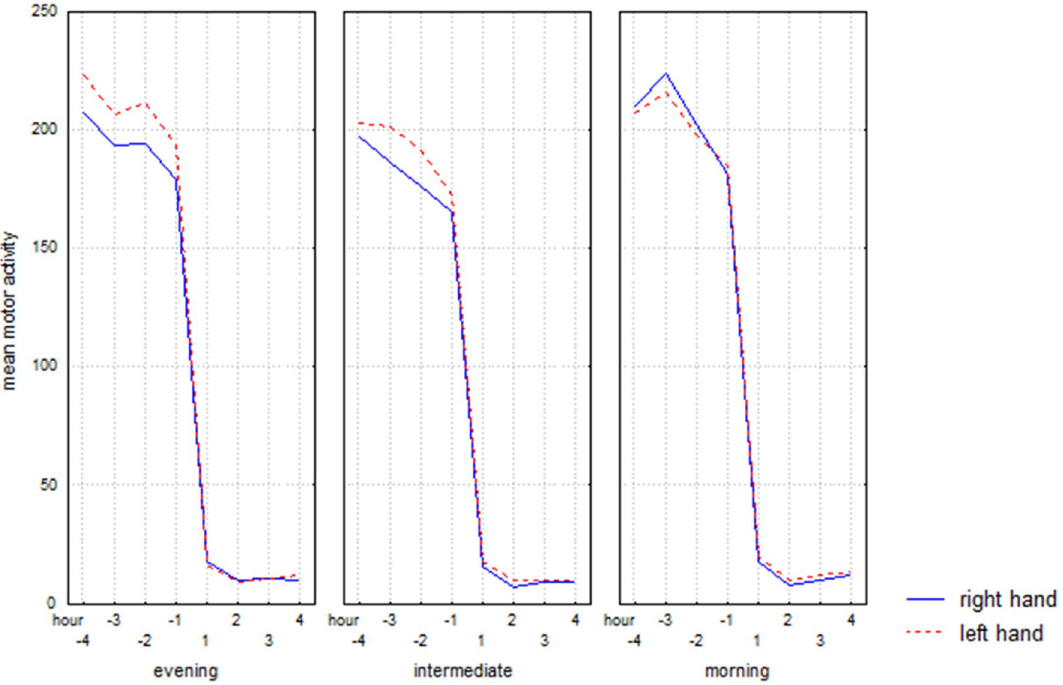
Figure 2. Hourly mean motor activity, over the time interval from four hours prior to bedtime (− 4, − 3, − 2, − 1) to four hours after bedtime (+ 1, + 2, + 3, + 4), of right and left hand in evening, intermediate, and morning types.